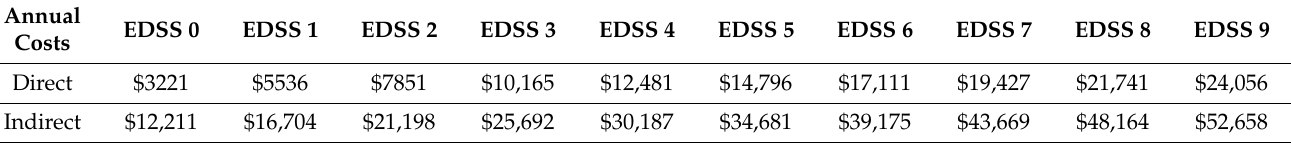
Table A6. Annual costs by EDSS state (US$ 2021).